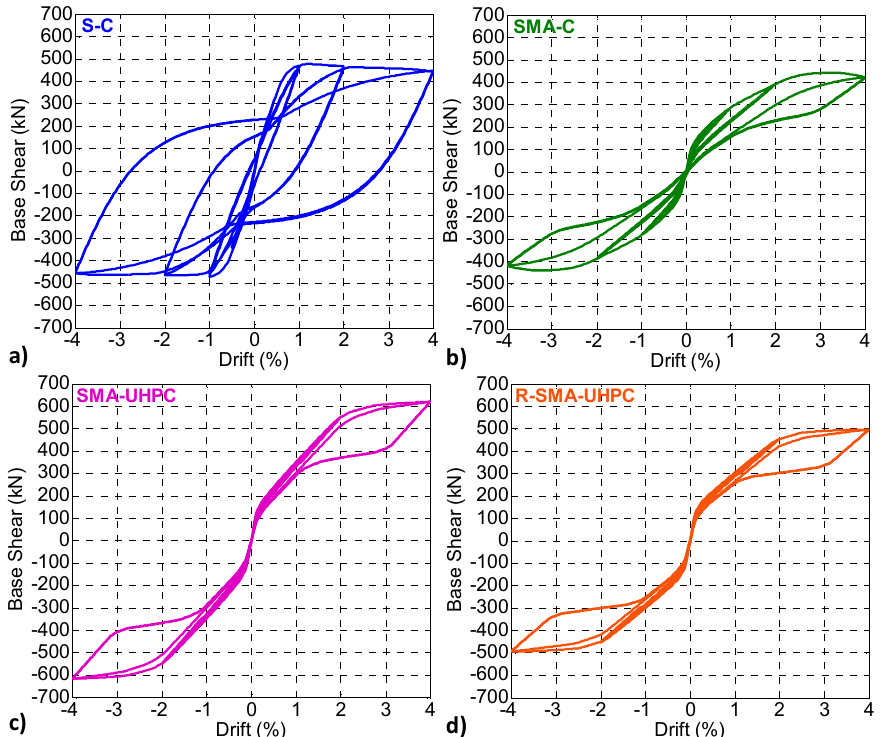
Figure 6. Base shear versus drift diagrams for different columns: ( a ) S-C, ( b ) SMA-C, ( c ) SMA-UHPC, ( d ) R-SMA-UHPC.